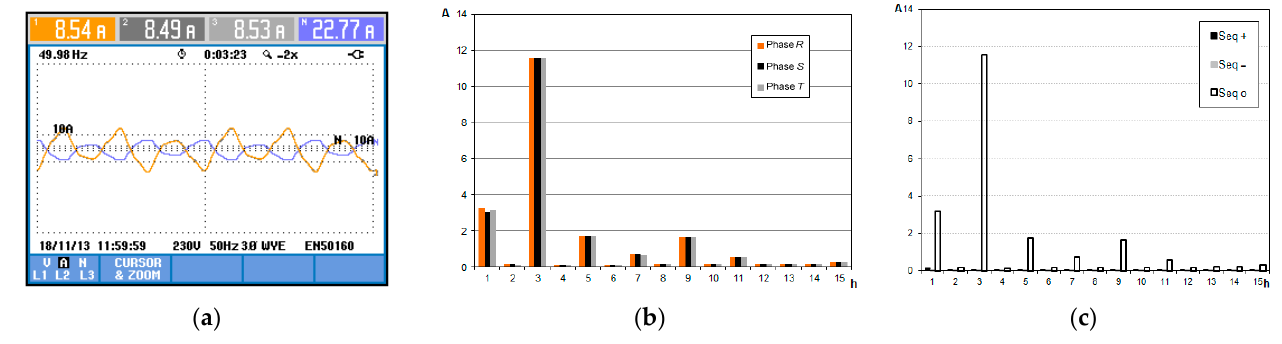
Figure 43. Measurements in the ZSF: ( a ) three-phase currents; ( b ) harmonic spectrum of the currents; ( c ) harmonic spectrum of the current sequence components (maximum values).